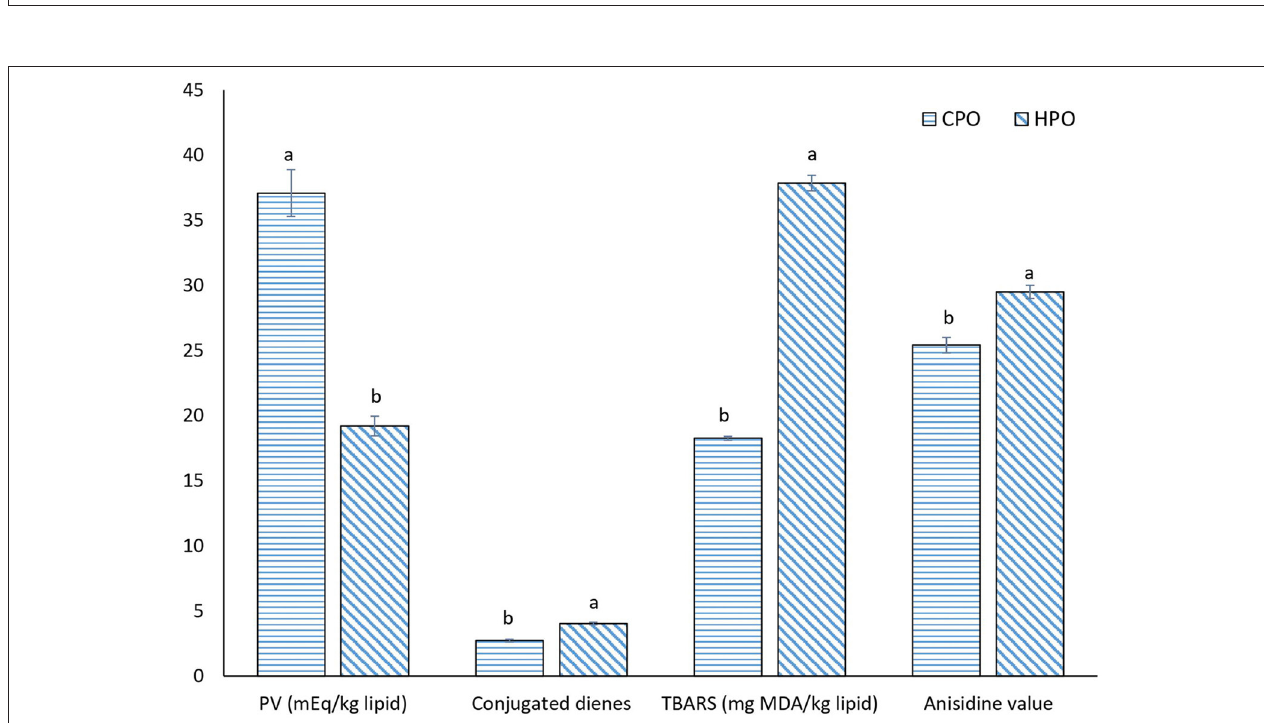
FIGURE 3 | Oxidation status of CPO and HPO. CPO: Oil extracted from cephalothorax; HPO: oil extracted from hepatopancreas. Different lowercase letters within the same oxidation index denote significant difference ( p < 0.05).